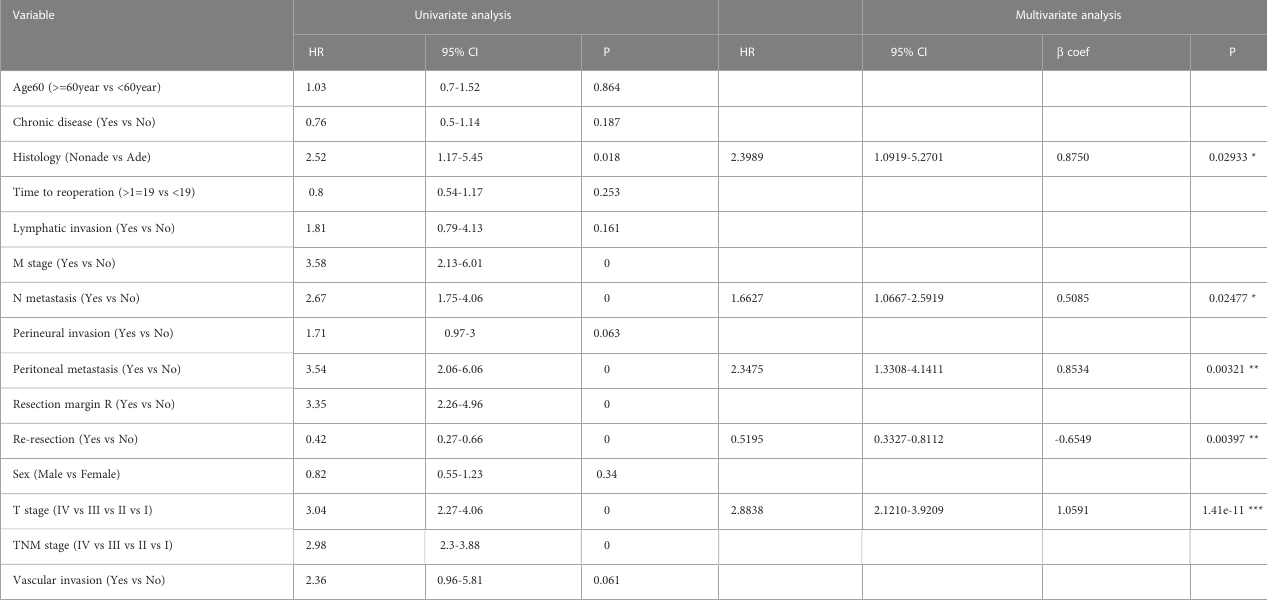
TABLE 2 Univariable and multivariable Cox analyses of OS in patients with IGBC.